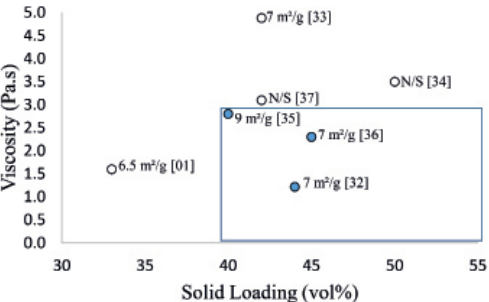
Figure 1. Comparison of the viscosity of published zirconia photosensitive slurries with their specific surface area labeled 1,32-37 at a shear rate of 30 s -1 and volume fraction. The dotted rectangle identifies the preferred characteristics for suspensions (solid loading ≥ 40 vol% and viscosity ≤ 3 Table 1. Monomers used in this study Monomer